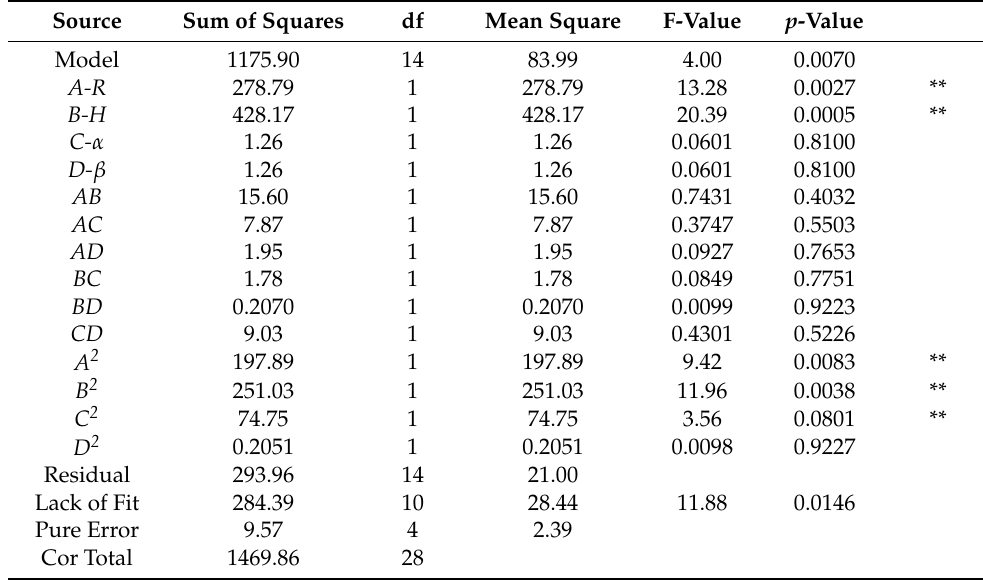
Table 8. ANOVA for Quadratic model of Rate of crushed soil.